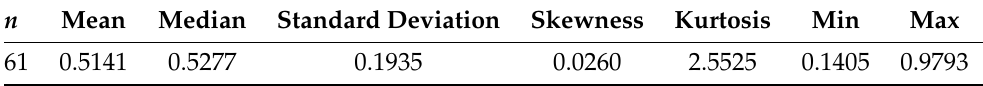
Table 7. Statistical summary for the trade share data